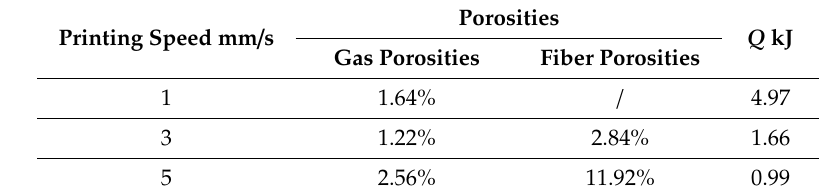
Table 4. Porosities in composites and calculated Q .